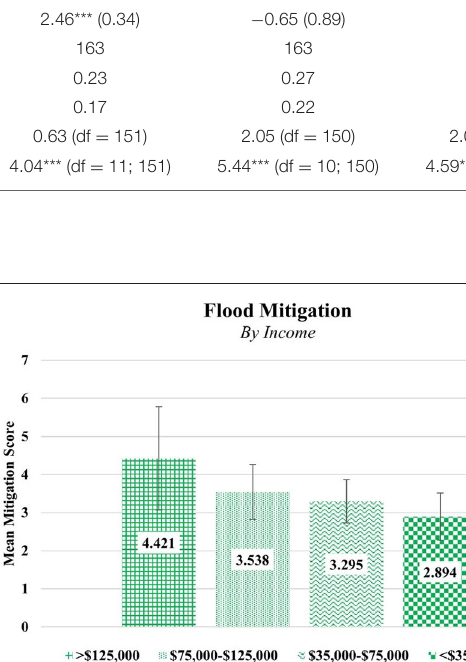
Frontiers in Water |